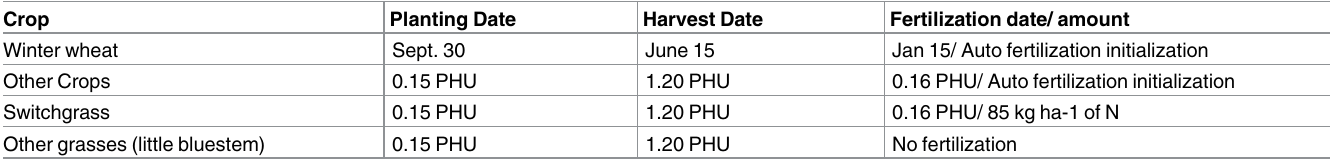
Table 1. Management practicesutilized in the SWAT model for the Skeleton Creek Watershed. Depending on the crop type either date or potential heat unit (PHU) was used when scheduling the operation.